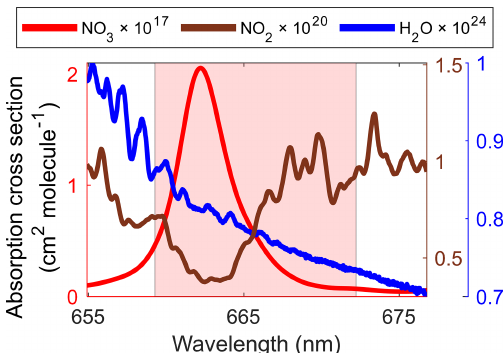
Figure 3. Absorption cross-sections of NO 3 , NO 2 , and H 2 O used and fitting range (shaded in light red) for number density